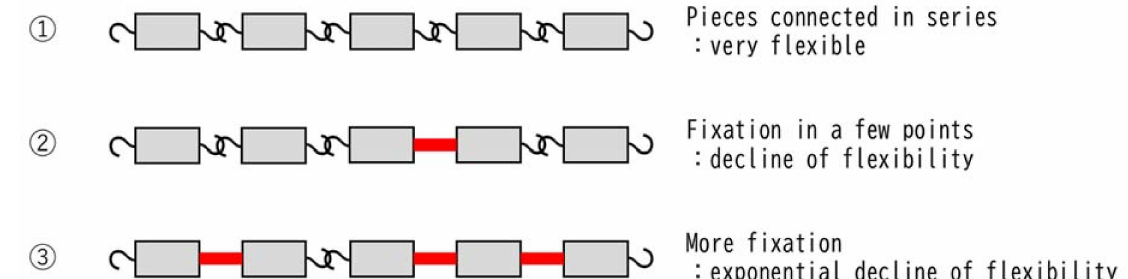
Figure 2. Mechanism underlying the synergistic effect produced by overlapping of the same reaction. Chains lose their flexibility exponentially each time their joints are fixed. The same can be said for the cascade of normal metabolic reactions, which are intracellular chain reactions. It is well-known that cells can maintain homeostasis even if they sustain some damage, but homeostasis suddenly collapses when a certain amount of damage is accumulated. The schema in this figure illustrates that 1 (cid:13) unfixed chains are very flexible and can take many forms; 2 (cid:13) the chain retains some flexibility even if the joint is fixed in several places; and 3 (cid:13) as the number of fixed joints increases, the forms that the chain can take decrease exponentially and are extremely